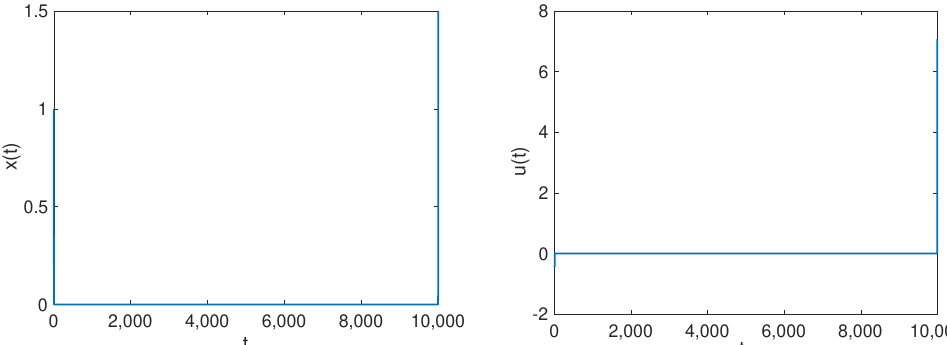
Figure 2. Hypersensitive: solution in time for the mass position x on the left and the control u on the right, final time T = 10 4